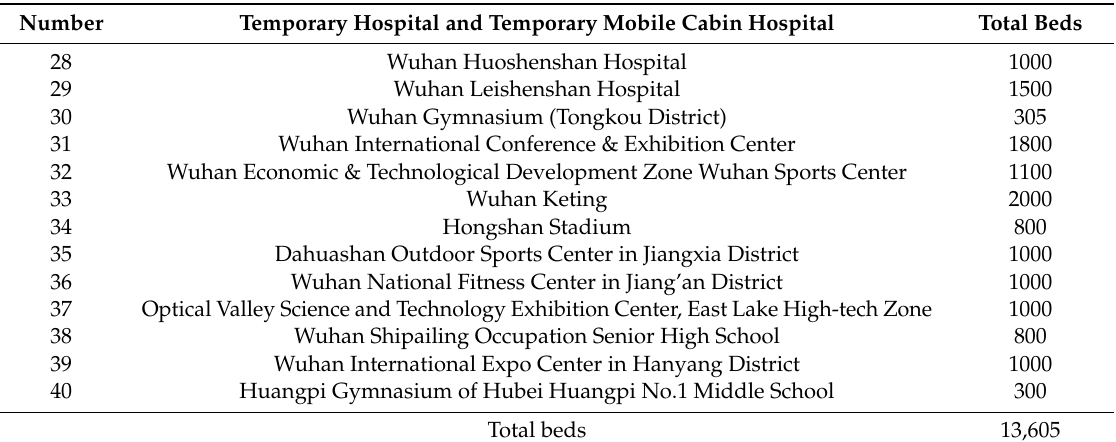
Table A2. Names and total beds of temporary hospitals and temporary mobile cabin